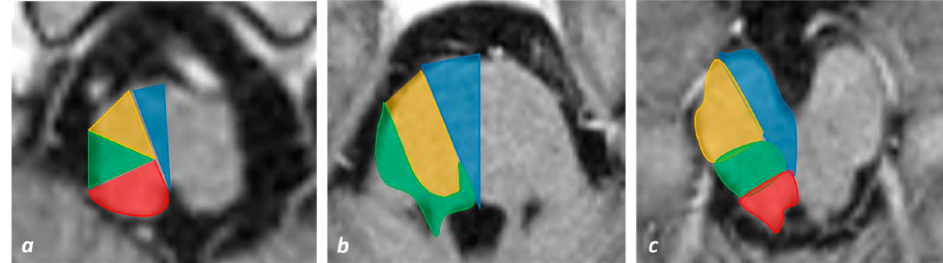
Figure 1. Vascular territories of the brainstem superimposed on axial T1W MRI slices . ( a ) Vascular territories at the level of the medulla oblongata: anteromedial group arteries (blue), anterolateral group arteries (yellow), lateral group arteries (green) and posterior group (red). ( b ) Vascular map at the level of the pons: anteromedial group (blue), anterolateral group (yellow) and lateral group (green). ( c ) Vascular territories at the level of the midbrain: anteromedial group arteries (blue), anterolateral group arteries (yellow), lateral group arteries (green) and posterior/dorsal group (red).